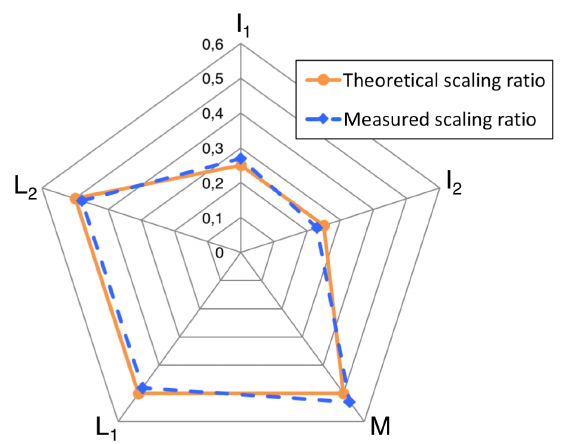
Figure 6. Comparison of theoretical and actual scaling ratios for self-inductances, mutual inductance and coils currents obtained downstream of the down-scaling.